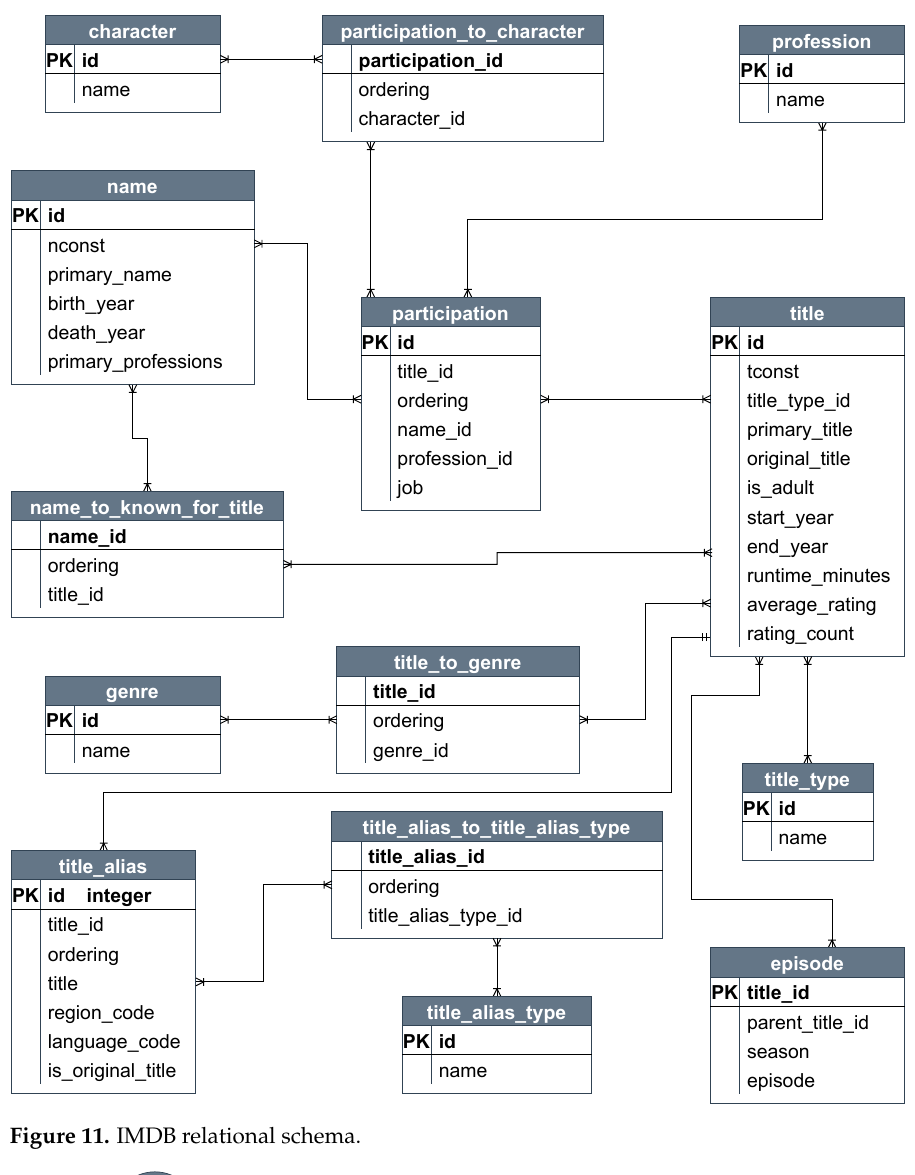
Figure 11. IMDB relational schema.